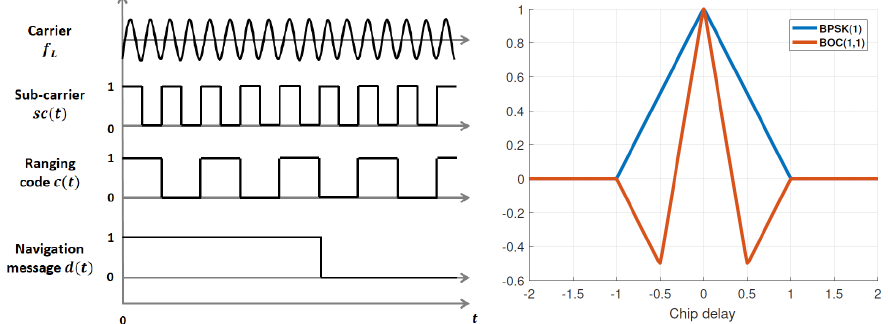
Figure 1. ( Left ) Multilayer GNSS signal structure. ( Right ) ACF for BPSK(1) and BOC(1,1)